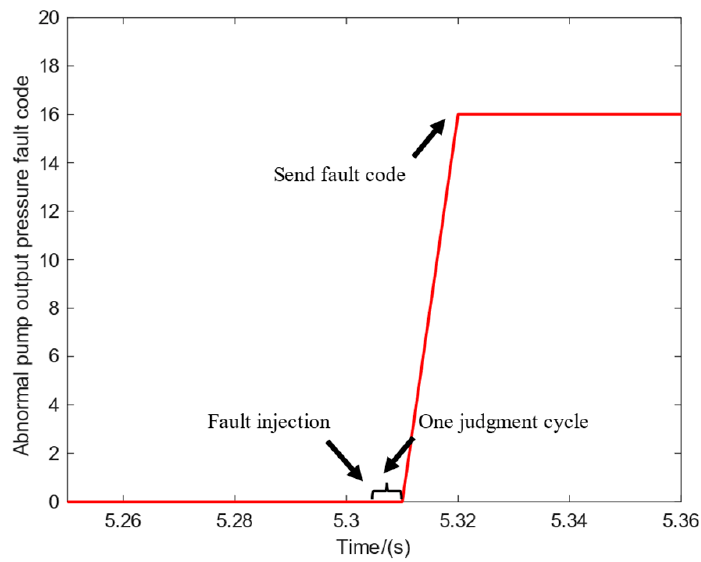
Figure 18. Fault code diagram of abnormal pump output pressure fault.